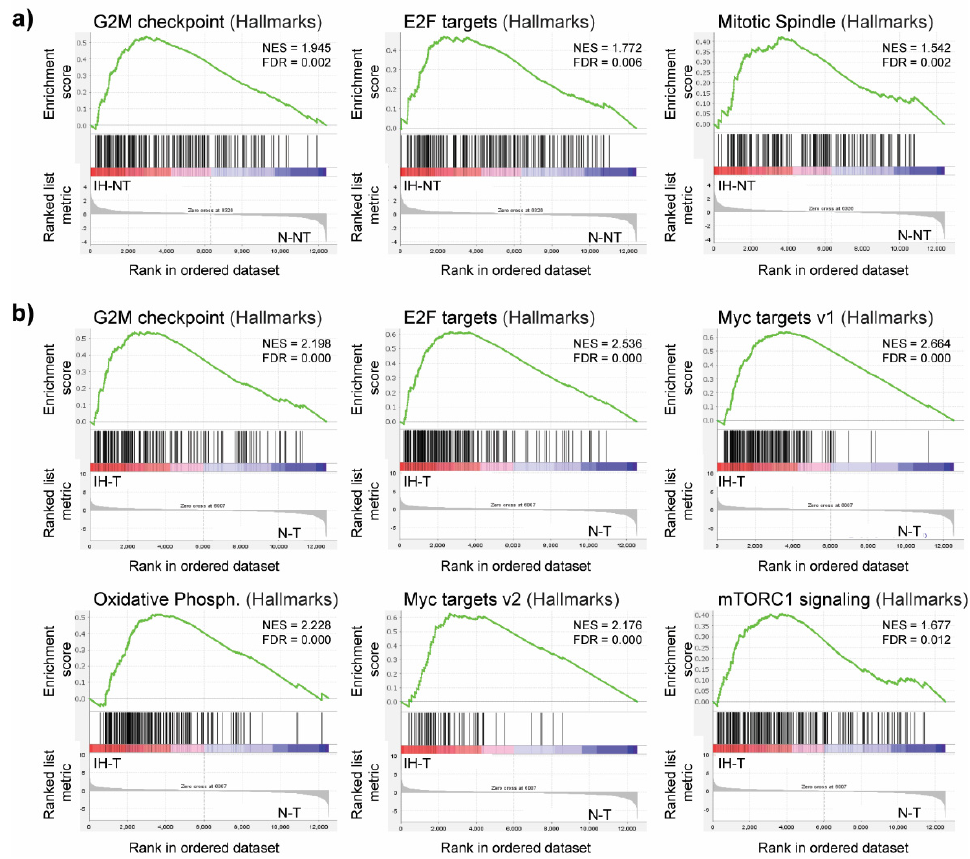
Figure 3. GSEA plots showing upregulated gene sets in the livers of DEN-treated rats following intermittent hypoxia treatment. ( a ) Enriched gene sets induced by intermittent hypoxia in non-tumor liver tissue (IH − NT) compared to normoxia (N − NT) in non-tumor liver tissue. ( b ) Enriched gene sets induced by intermittent hypoxia in tumor tissue (IH − T) compared to normoxia (N − T) in tumor tissue. NES, normalized enrichment score; FDR, false discovery rate.